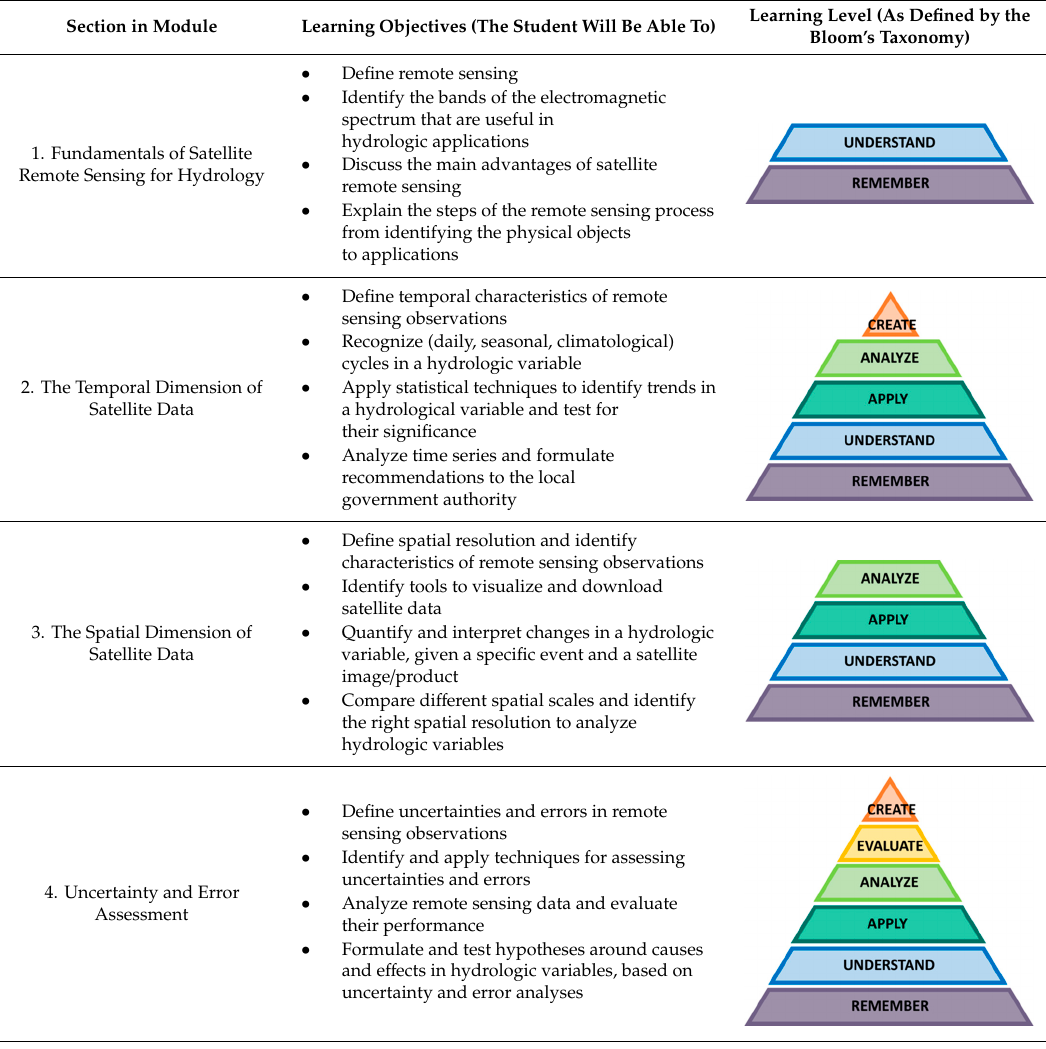
Figure 1. Bloom’s Taxonomy adopted from the Vanderbilt University Center for